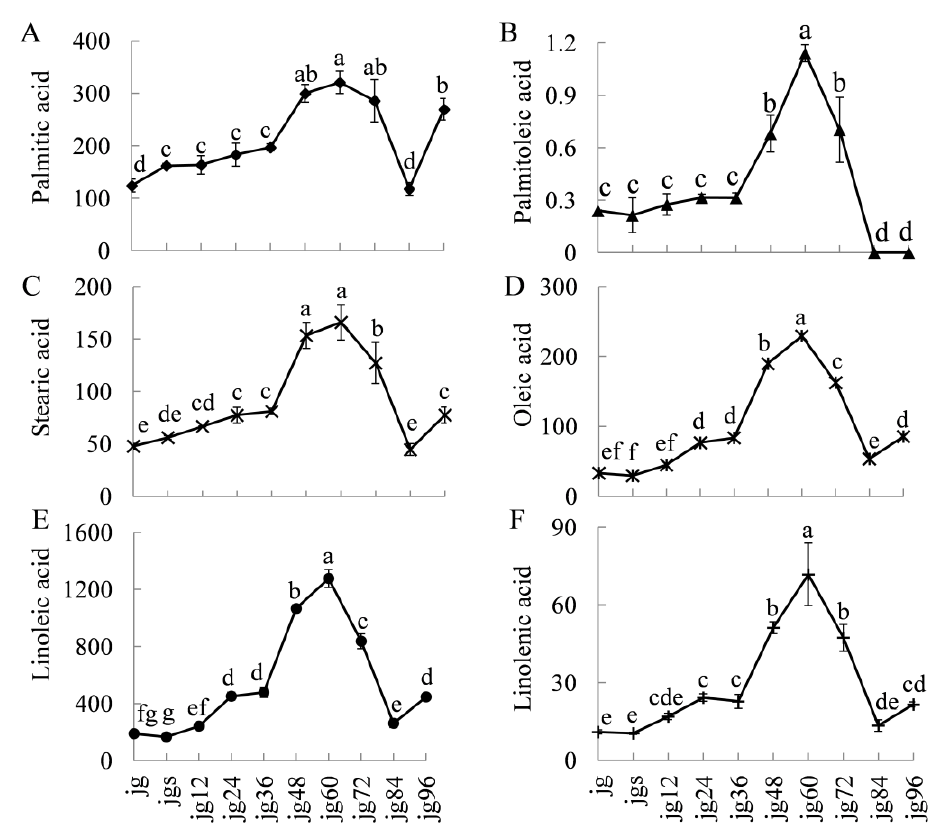
Figure 3. Variations in the contents of the fatty acids (mg kg −1 ) during millet germination. The significance of the differences (different letters) was determined at p < 0.05. Data were shown as the mean ± SD values (n = 3). jg, jgs, and jg 12–96 represented raw brown millet, soaked brown millet, and germinated millet for 12, 24, 36, 48, 60, 72, 84, and 96 h, respectively.